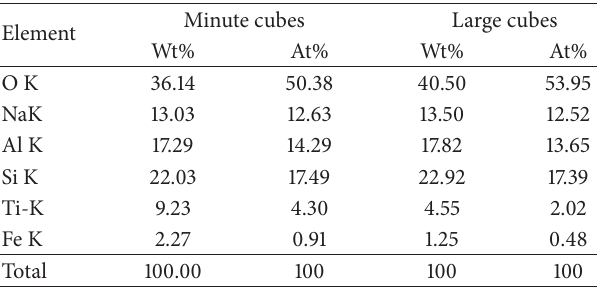
Table 3: EDX analysis for Ti-Zeolite (Ti-ZA). Minute cubes Element